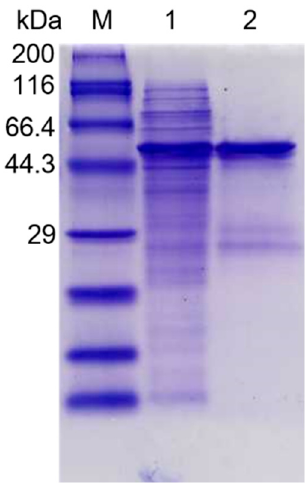
Figure 3. SDS-PAGE analysis of recombinant PpPel10a. M, molecular weight markers; lane 1, supernatant of lysed recombinant E. coli BL21 (DE3) cells carrying plasmid pET28a-pppel10a; lane 2, PpPel10a purified by Ni-NTA column chromatography.